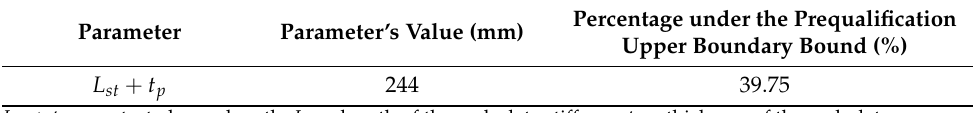
Table 10. Percentage of the dimensional noncompliance of the protected zone